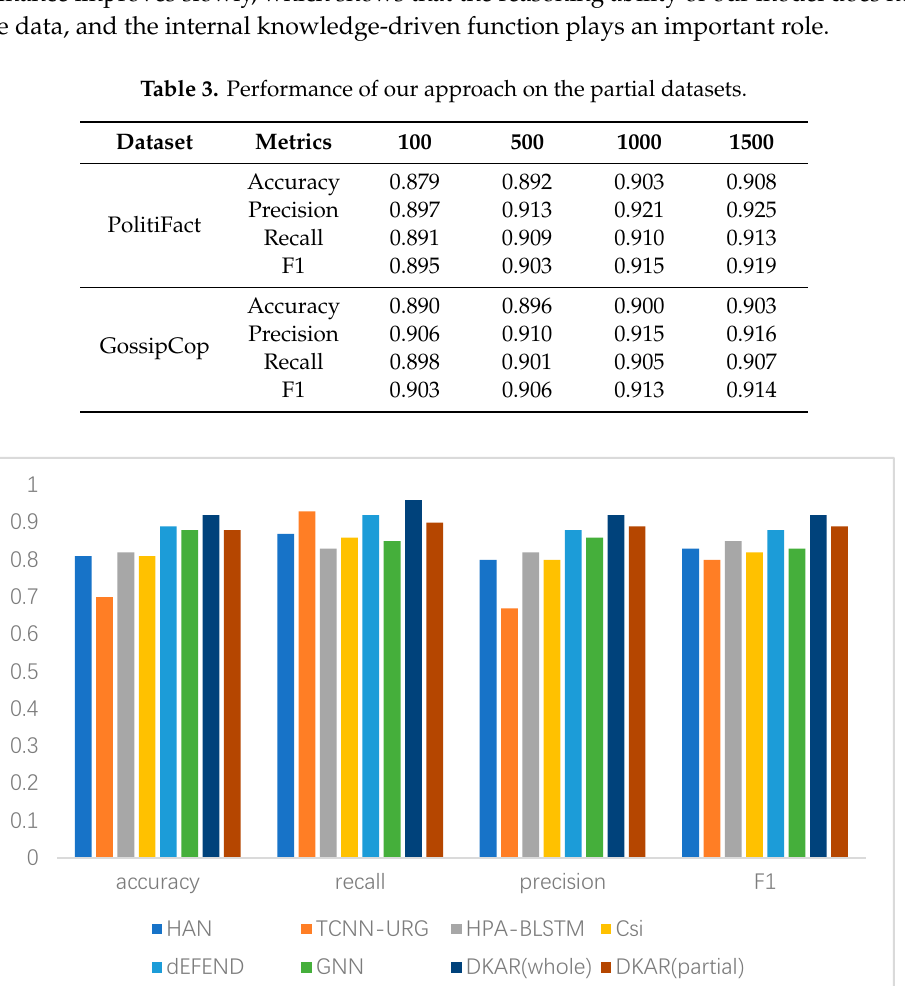
Figure 6. Performance comparison on the dataset of GossipCop. Table 3. Performance of our approach on the partial datasets. Dataset